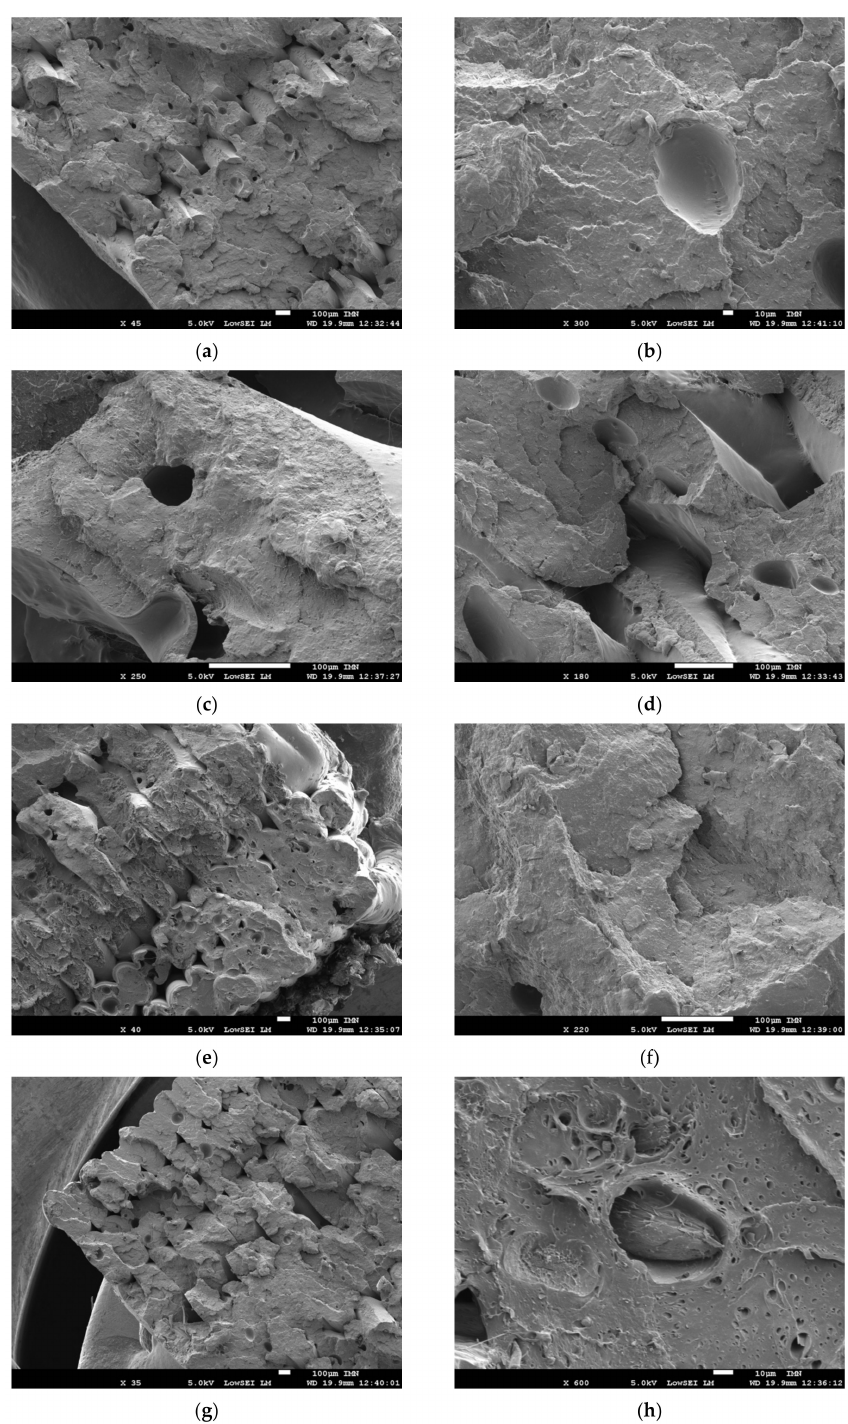
Figure 8. SEM micrographs of the fractured surfaces in 3D printed Wood-PLA / PHA after tensile loading showing di ff erent features: ( a ) raster, ( b ) process-induced porosity, ( c ) frame, ( d ) wood fibre, ( e ) fibre pull-out, ( f ) PLA / PHA matrix, ( g ) filament morphology, ( h ) fracture pattern within the matrix. The printing temperature is 250 ◦